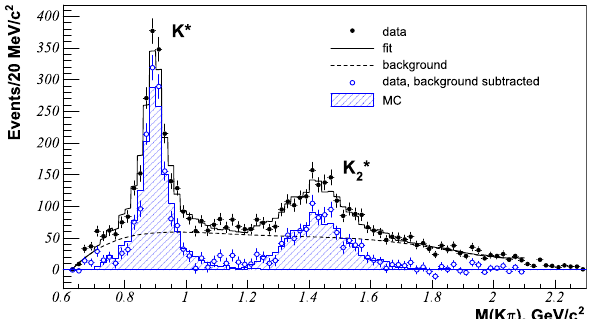
Fig. 5 Masses of K + π − and K − π + in selected signal events of J /ψ → K + K − π + π − decays. Close circles are experimental data, black solid lines are the sums of MC histograms for the correspond- ing decays through resonances (hatched histograms) and backgrounds